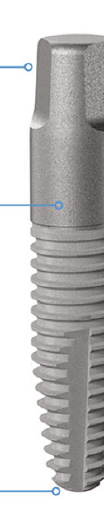
Figure 1: Features of the one-piece conical titanium